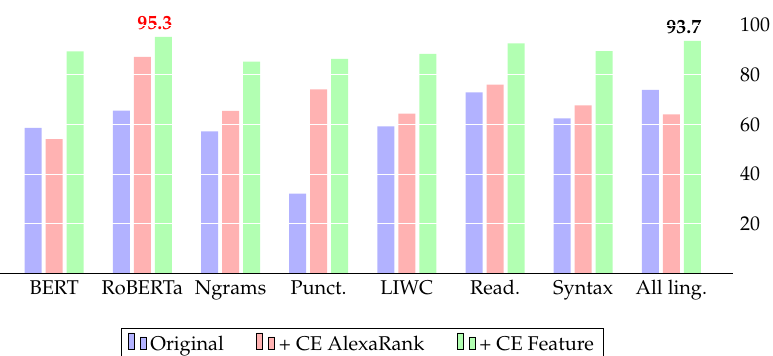
Figure 5. Results on FakeNewsAMT dataset ( F 1 score): adding proposed Cross-lingual Evidence (CE) improves various baseline systems and yields state-of-the-art results with RoBERTa model.